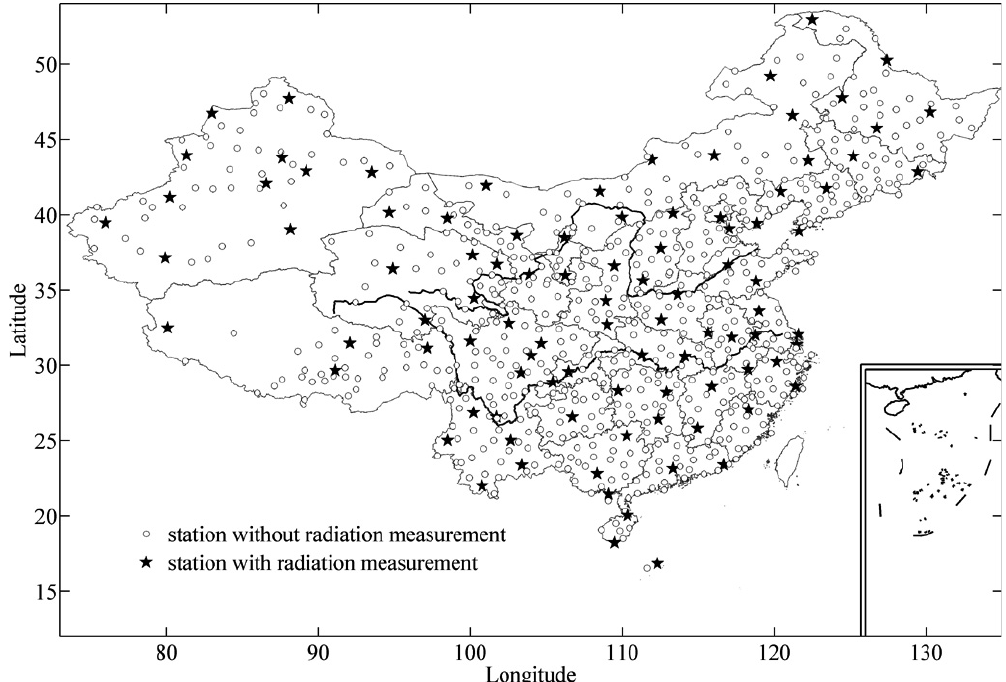
Fig. 1. The spatial distribution of 716 CMA stations, among which there are 96 radiation stations denoted by five-pointed star symbols.